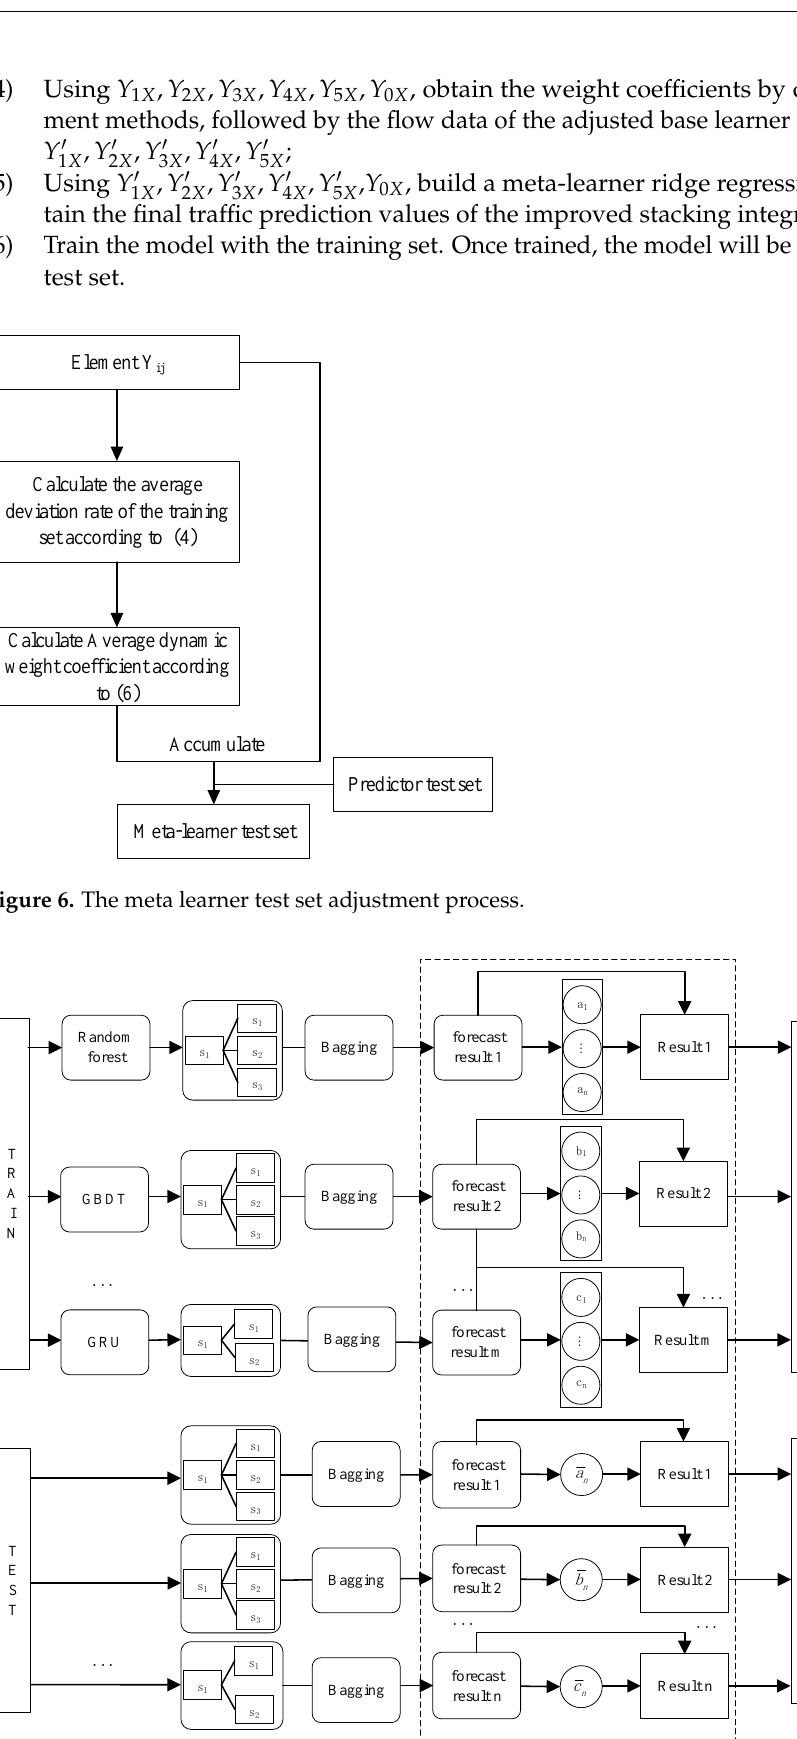
Figure 7. The DW – Ba – stacking model principle diagram (ridge regression). Figure 7. The DW-Ba-Stacking model principle diagram (ridge